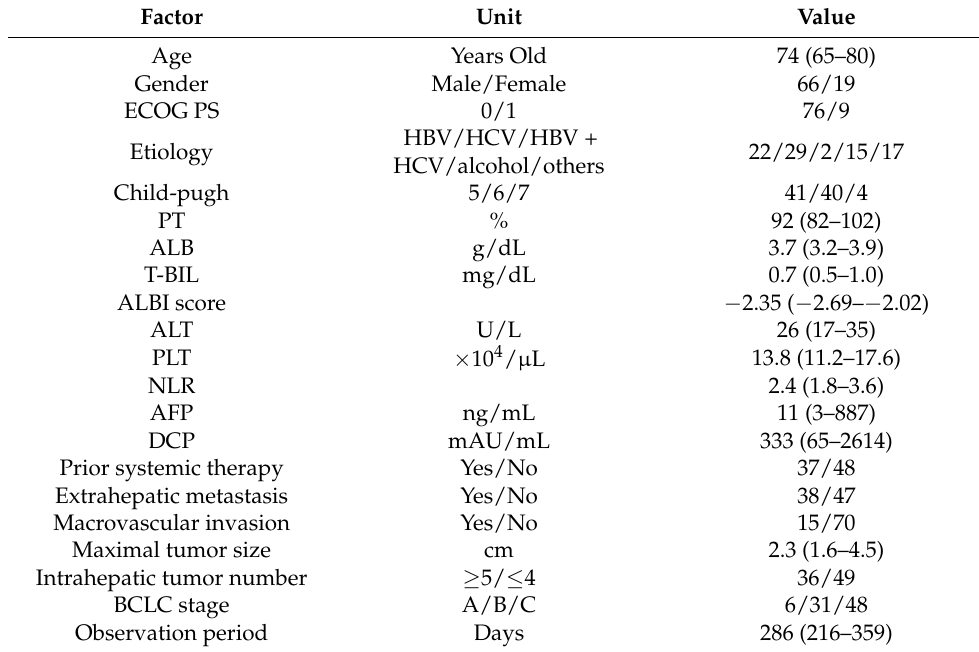
Table 1. The clinical characteristics of 85 HCC patients enrolled in this study.